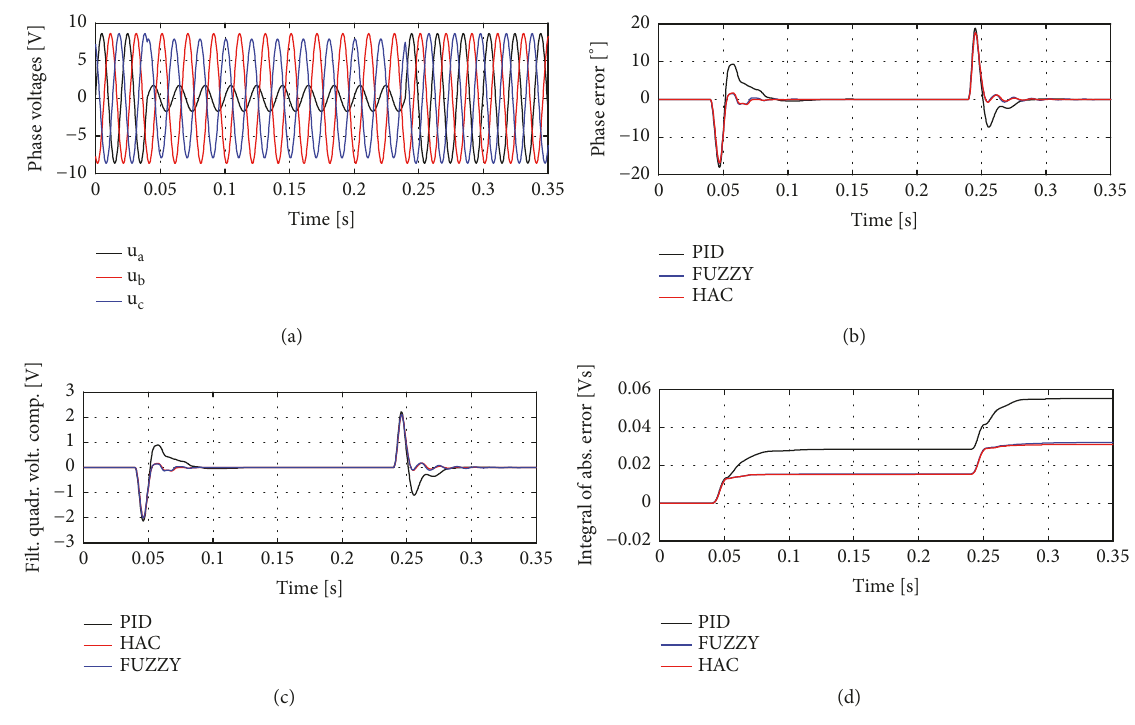
Figure 10: Phase voltages (a), phase error (b), filtered quadrature voltage component 𝑢 𝑞 (c), and integral of absolute error (d) for the unbalanced voltage sag in phases a and c.